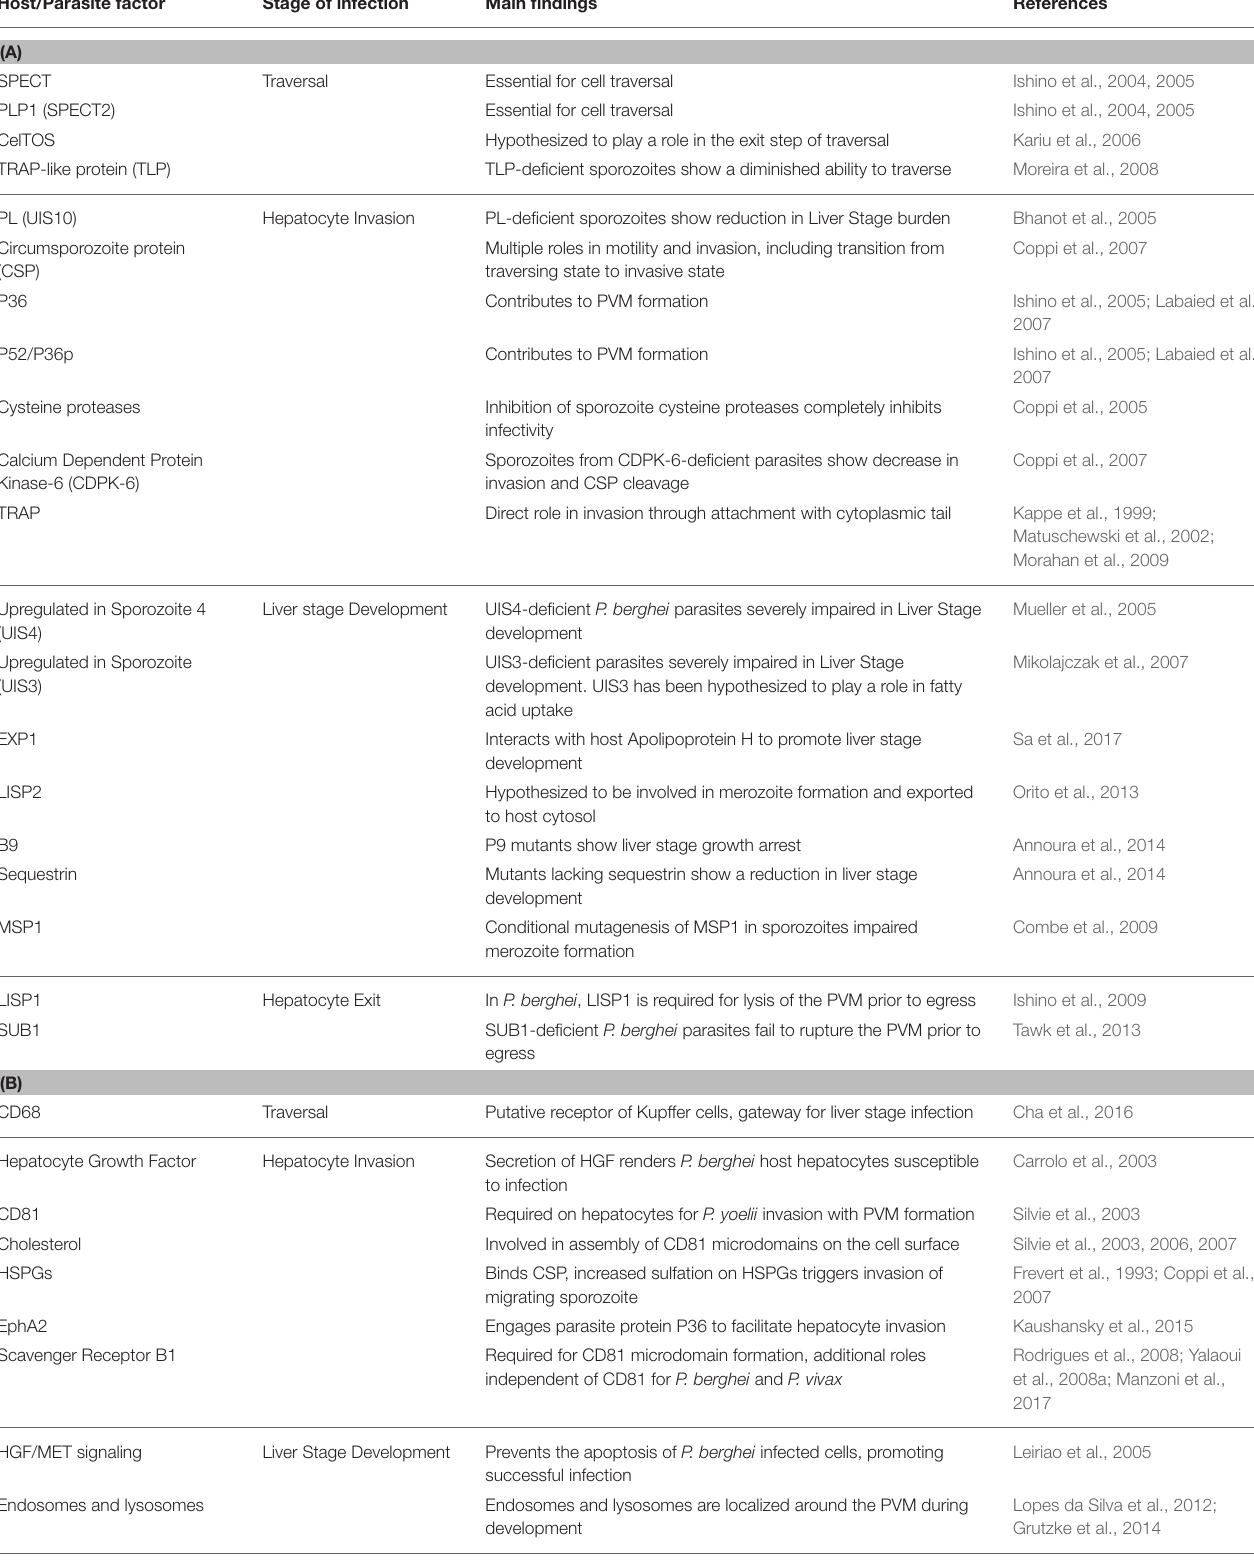
TABLE 2 | Determinants of hepatocyte liver stage infection: (A) Plasmodium determinants of infection and (B) Host determinants of